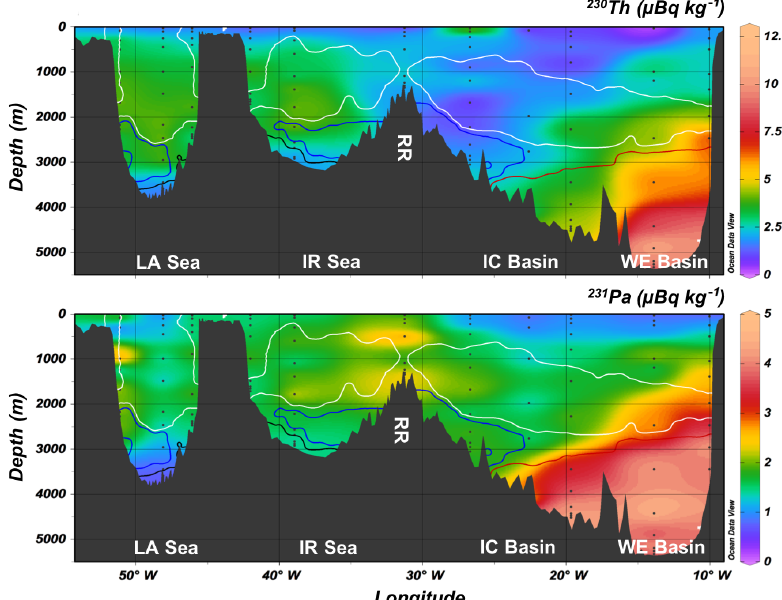
Figure 5. Distribution of 230 Th and 231 Pa along the GEOVIDE section. Water masses were indicated by contours (black: DSOW; blue: ISOW; white: LSW; red: NEADW) based on 50% level percentage composition of source water types from eOMP